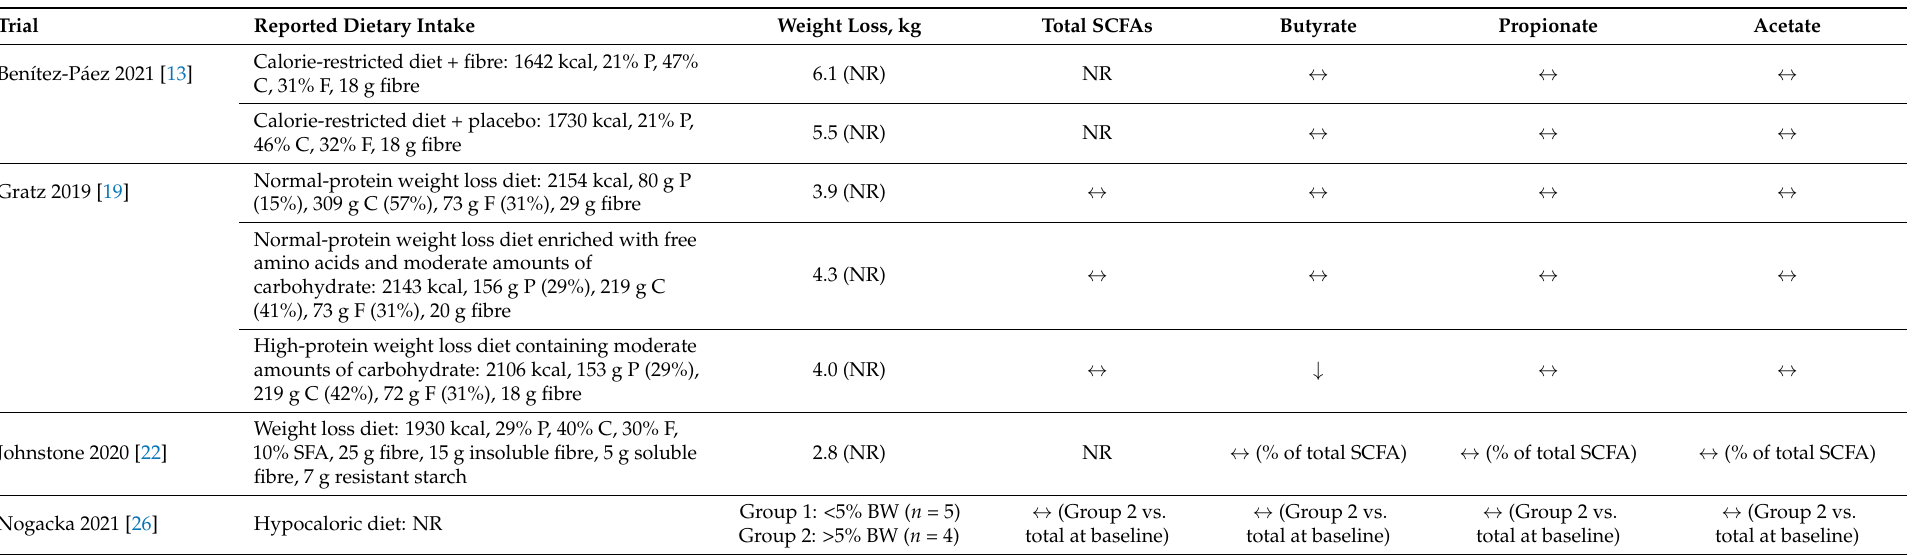
Table 3. Changes in faecal short-chain fatty acid